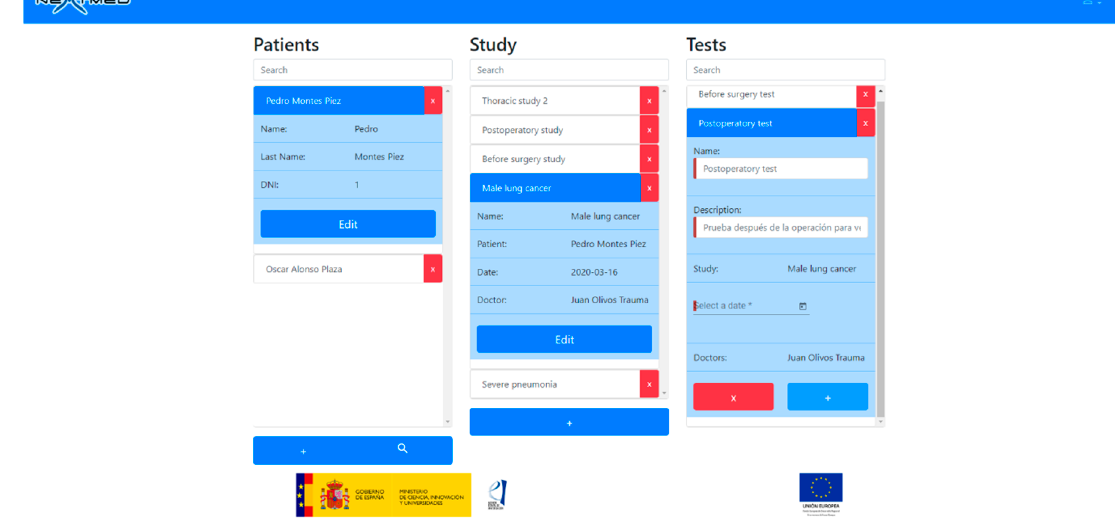
ff erent patients (patient data are not real).